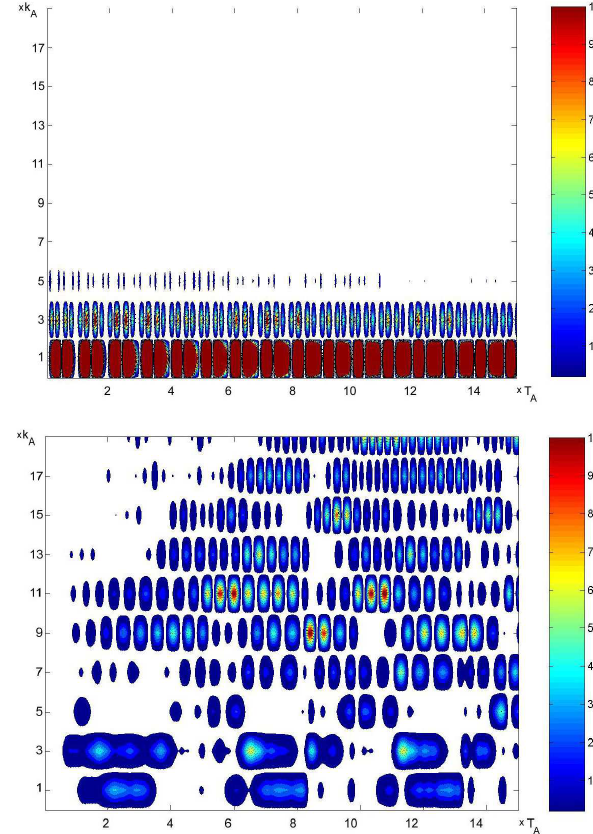
Fig. 5. Time dependence of spatial spectra of the magnetic field perturbation B y (t,k) ( a ) , and the parallel electric field E x (t,k) ( b ) . Horizontal axes give the time in T A units, and vertical axes give the wave number in k A units. The values of B y (t,k) and E x (t,k) are shown in arbitrary units by color